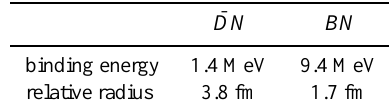
Table 1. The properties of the ¯ DN and BN bound states for J P = 1 / 2 − with I = 0.